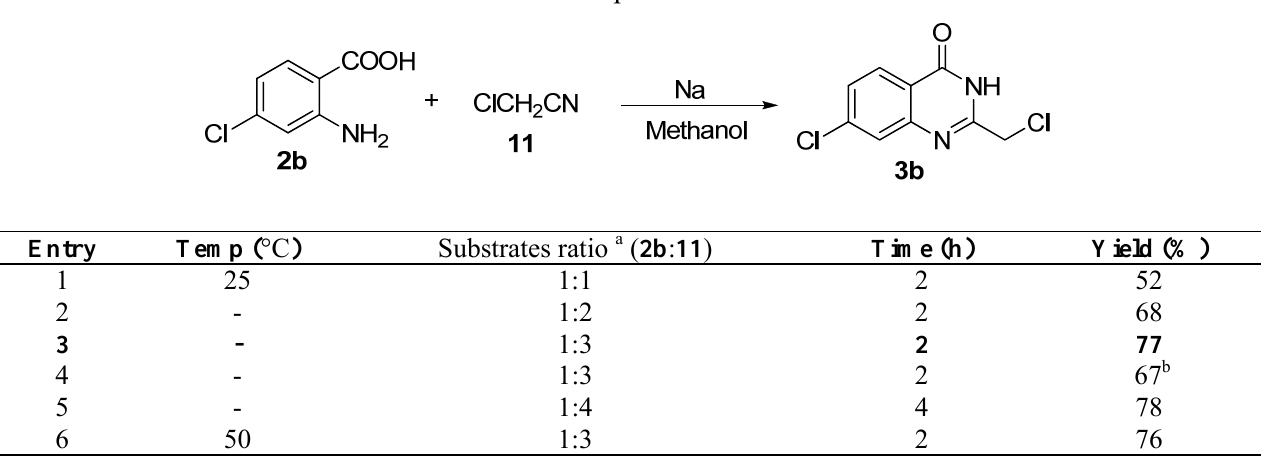
Table 1. The conditions optimization for substrate 2b .